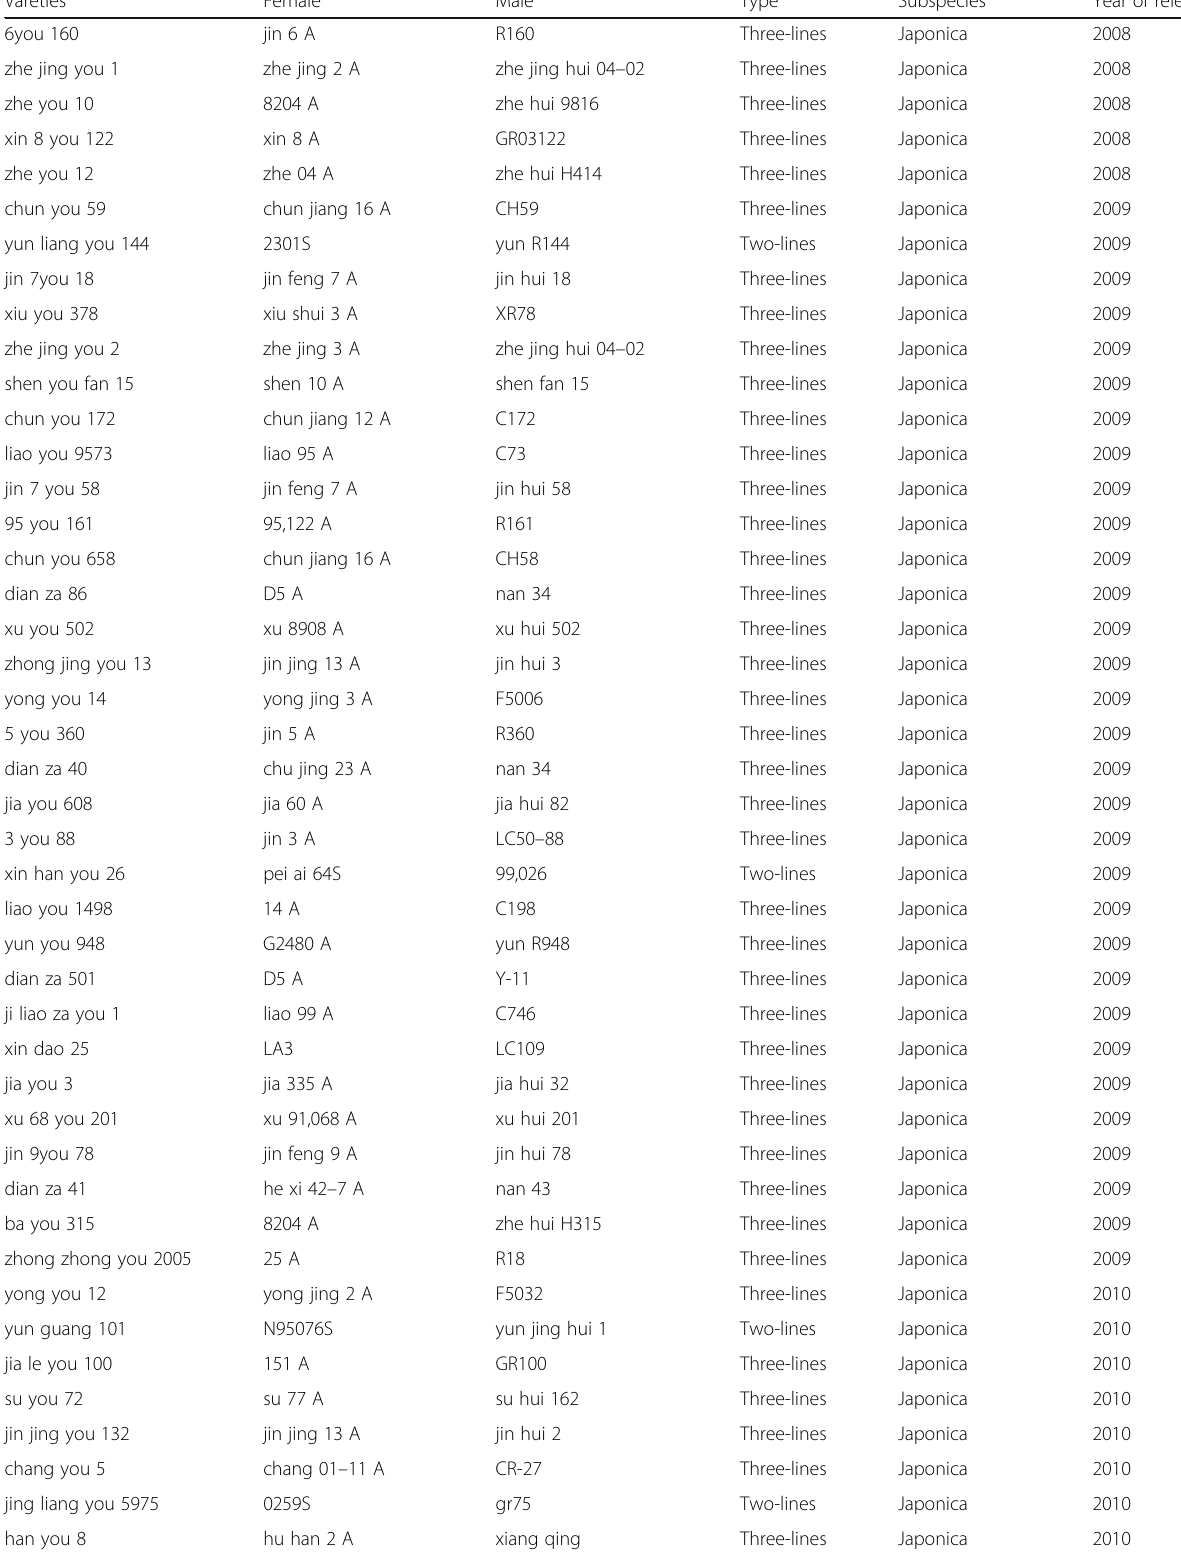
Table 1 List of hybrid japonica rice varieties bred in China (Continued)